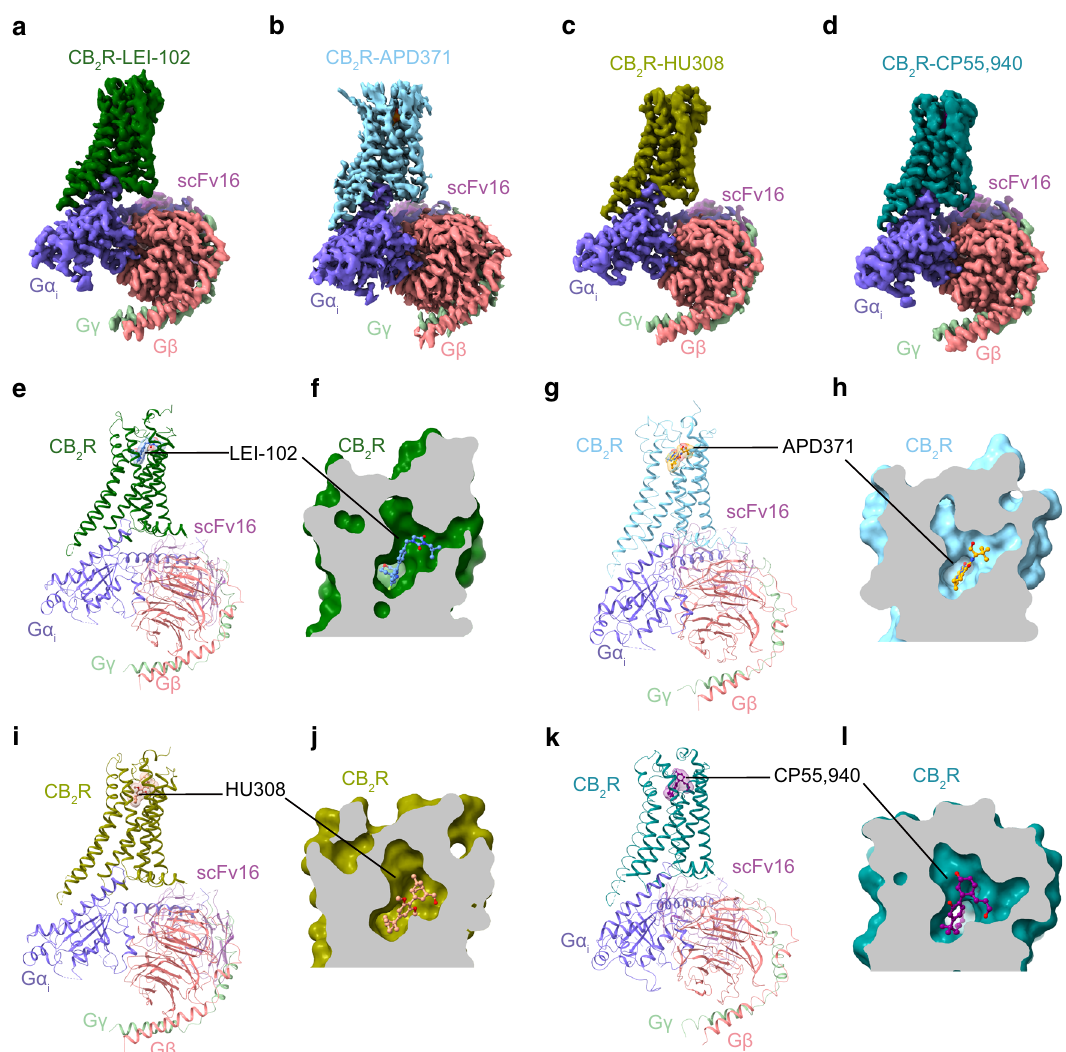
Fig.2|Cryo-EMstructuresofCB 2 R-G i complexes. Cryo-EMdensitymapsof a LEI- 102 (Dark green), b APD371 (Sky blue), c HU308 (Olive), and d CP55,940 (Teal) bound CB 2 R in complex with G α i (Slate), G β (Salmon), G γ (Pale green), scFv16 (Violet purple). e – l Overall structures of CB 2 R-G i complexes and enlarged view of